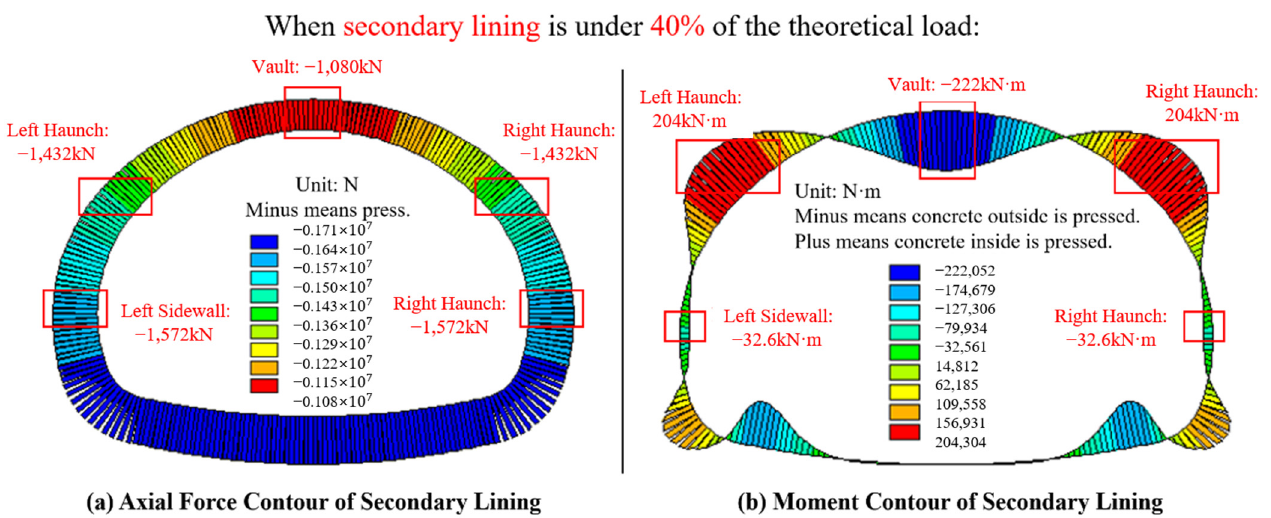
Figure 11. Moment (N.m) and axial-force (N) diagram of the secondary lining in simulation.